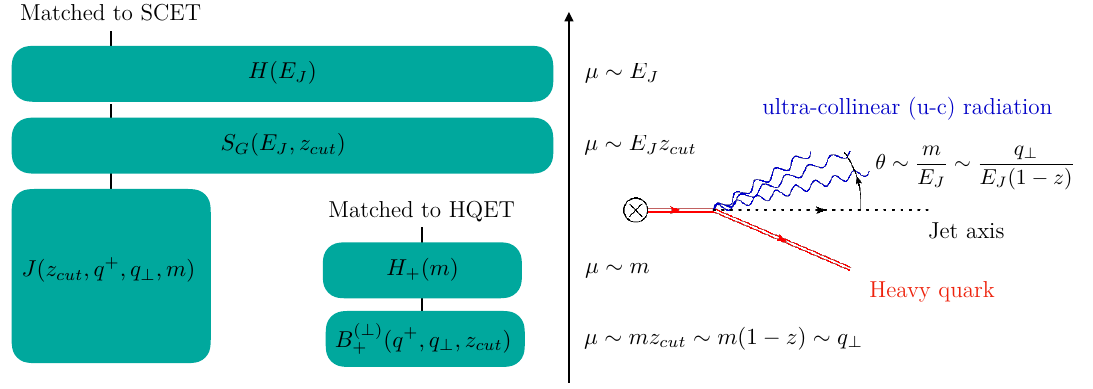
Figure 1 . Hierarchy of scales in region 1 factorization ( q radiation mode which contributes to both the z and q boosted soft mode of HQET (referred to as the ultra-collinear or u-c